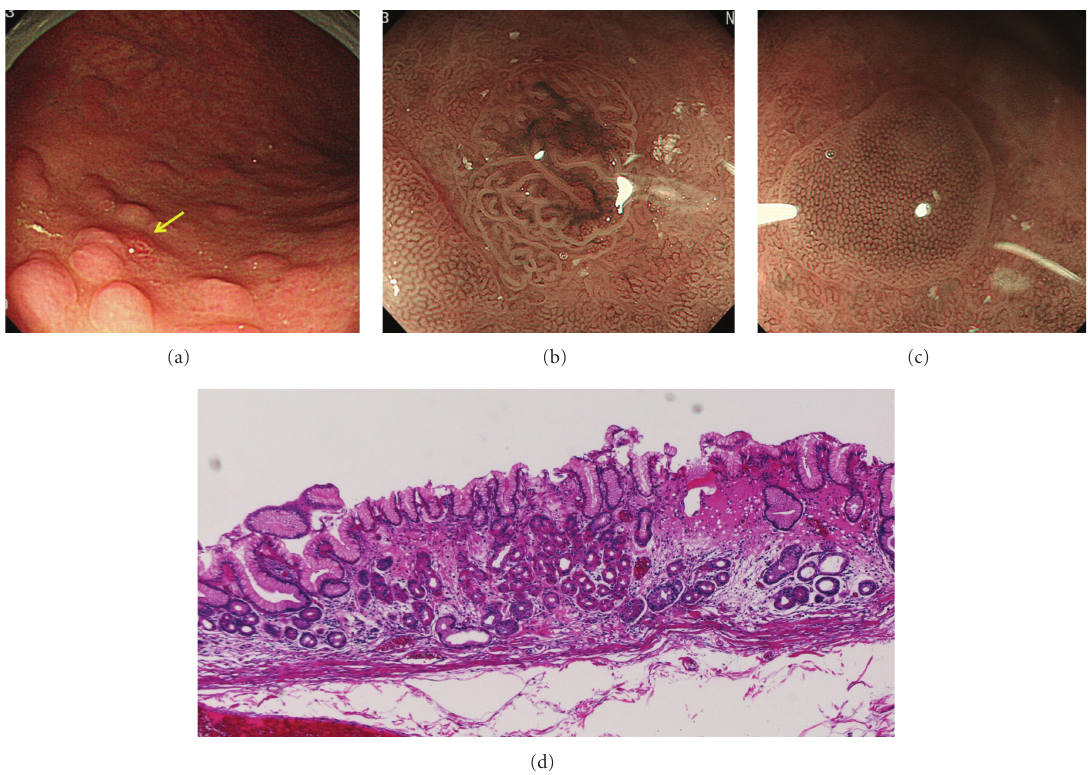
Figure 2: (a) Conventional endoscopic findings in Case 3. Yellow arrow shows a nodule with redness. (b) Magnifying endoscopic appearance of the nodule with redness in Figure 2(a) (full zoom). (c) Magnifying endoscopic appearance of the other nodules in Figure 2(a) (full zoom). (d) Histological appearance of the other nodules in Figure 2(c). Atrophic mucosa with fundic gland remnants is